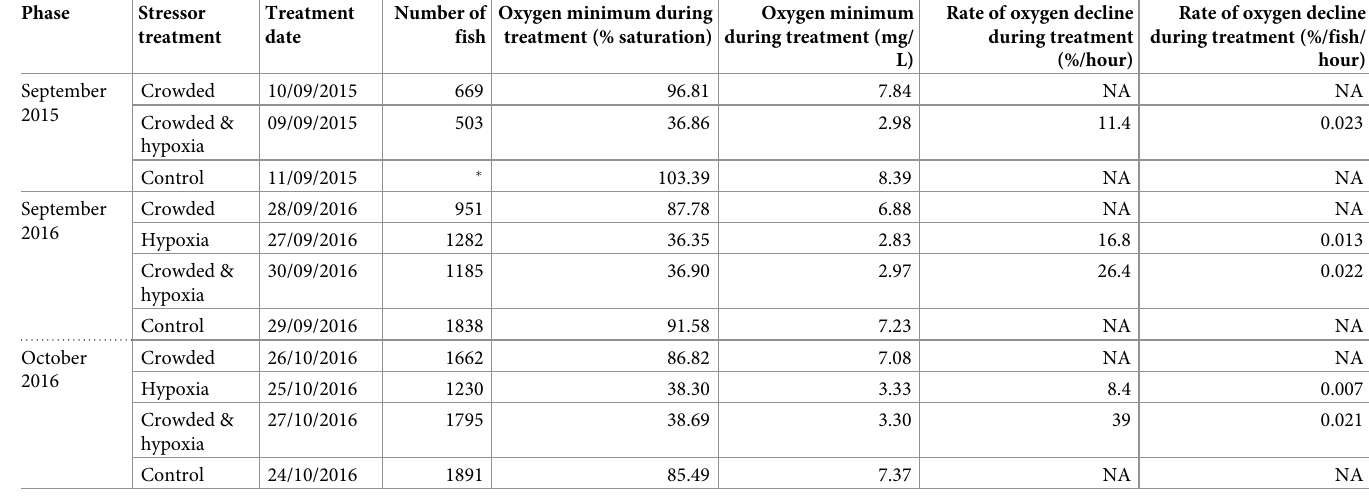
Table 2. Experimental design. Numbers of fish exposed to stressor treatments and associated rates of oxygen decline throughout the three phases of the experiment. Phase Stressor